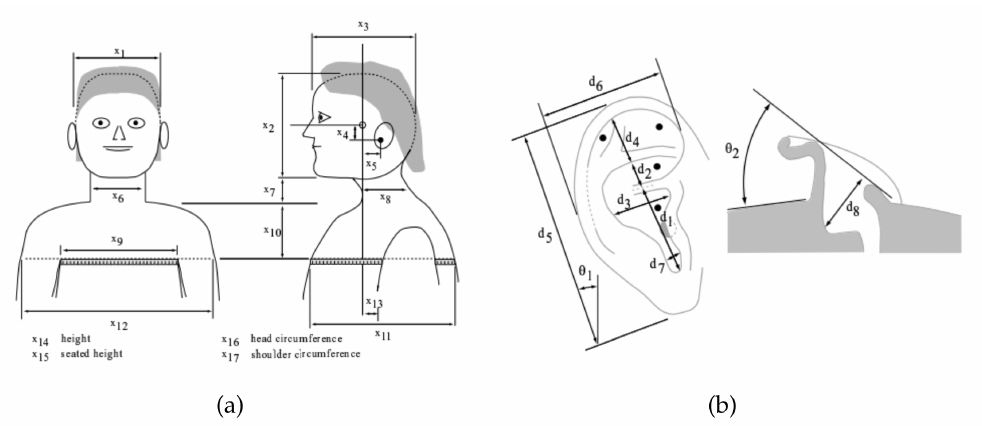
Figure 2. Anthropometric measurements: ( a ) head and torso measurements and ( b ) pinna measurements